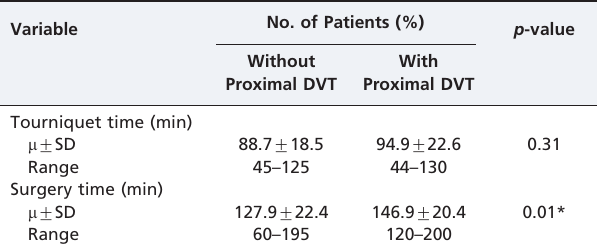
Table 4 - Analysis of patients with proximal DVT and patients without proximal DVT by tourniquet (n =74) and operative times (n= 78) and a comparison of